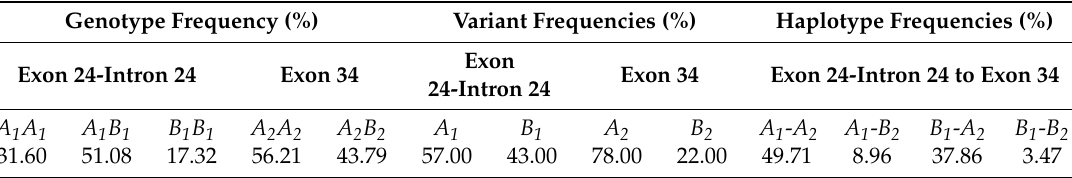
Table 2. Genotype, variant, and haplotype frequency of yak FASN.